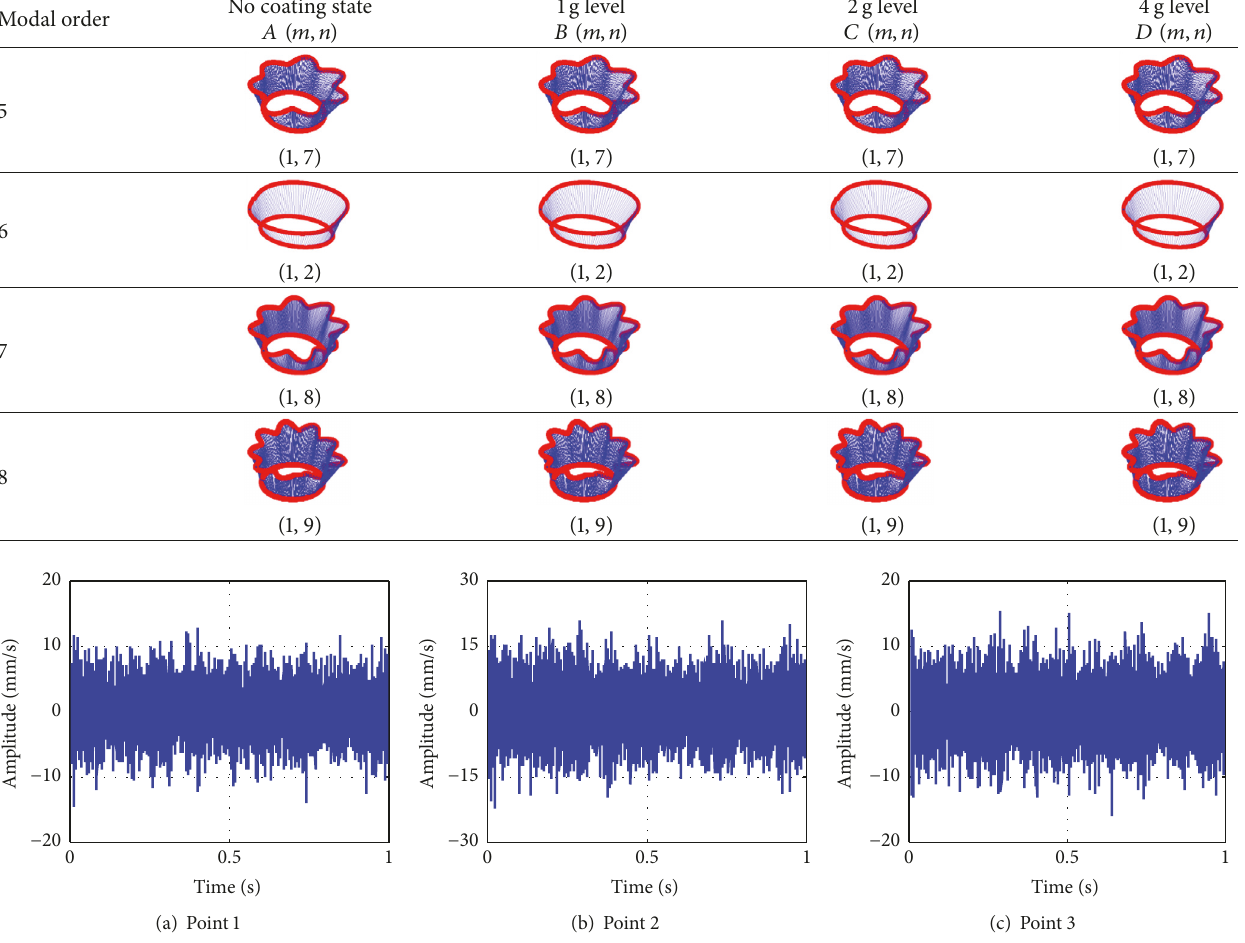
Figure 11: The measured time waveforms of cantilever cylindrical shell without hard coating at 3 measuring